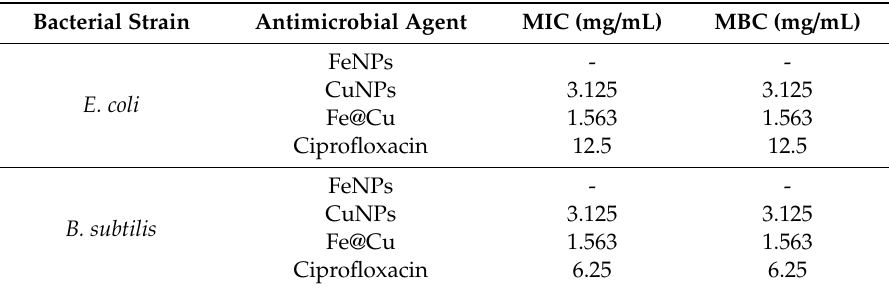
Table 4. Antimicrobial activity of nanoparticles in comparison with ciprofloxacin. Bacterial Strain